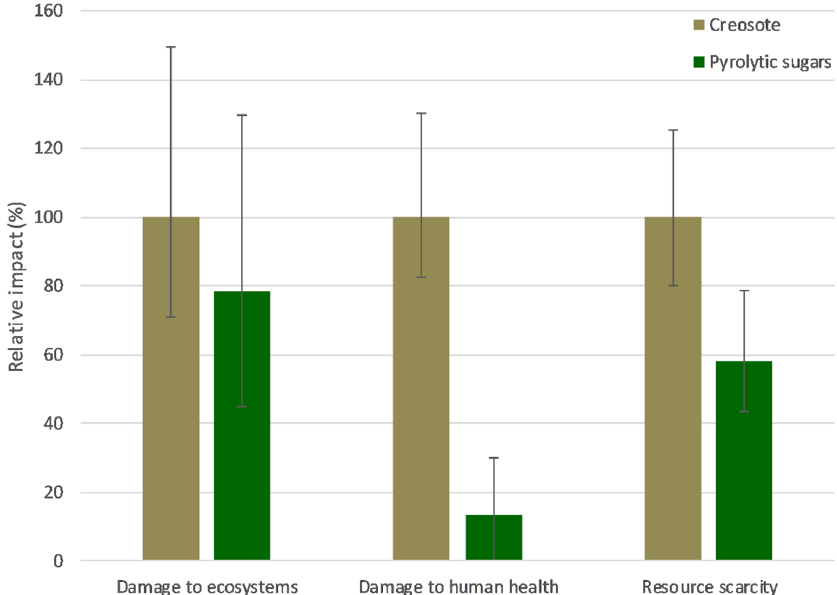
Figure 3. Relative environmental impact of 1 m 3 a pyrolytic sugar treated wooden poles compared to creosote treated wooden poles. Error bars represent the 95% confidence interval.